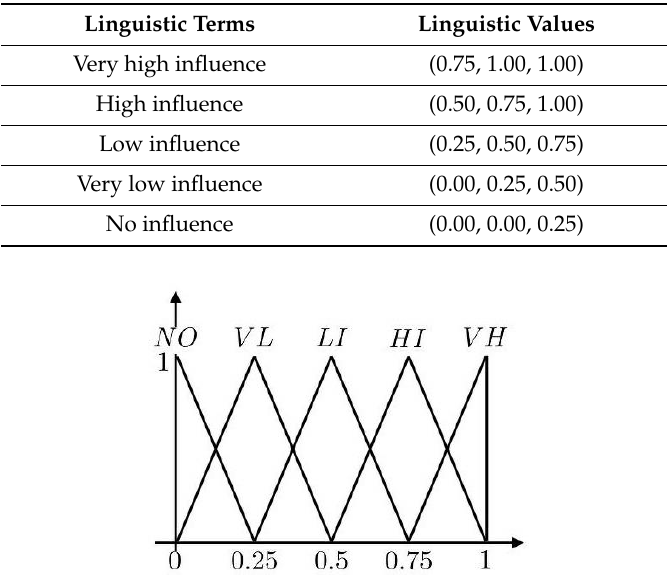
Figure 1. Triangular fuzzy numbers for linguistic variables. VH, Very high influence; HI, High influence; LI, Low influence; VL, Very low influence; NO, No influence.